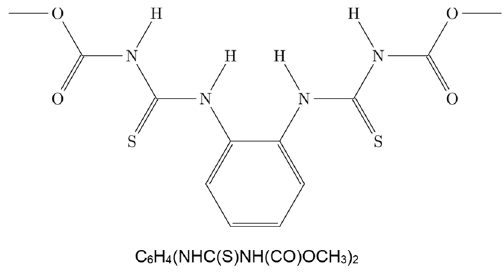
Figure 1. Chemical structure of thiophanate methyl [32].